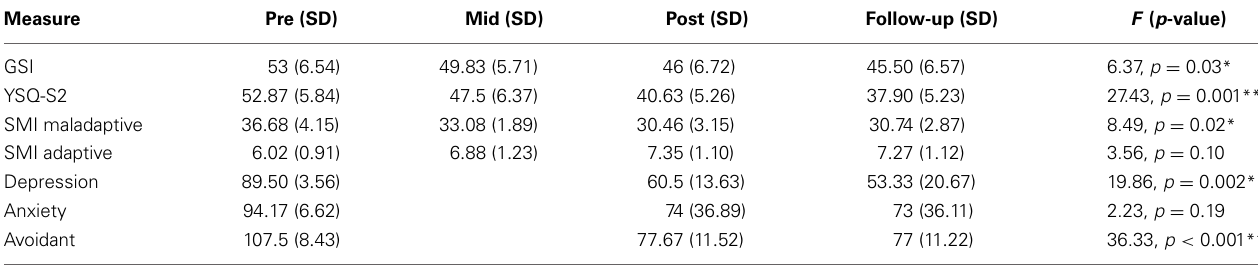
Table 3 | Means, standard deviations, F statistics and p -value’s of all questionnaire measures as a result of the repeated measures ANOVA. Measure